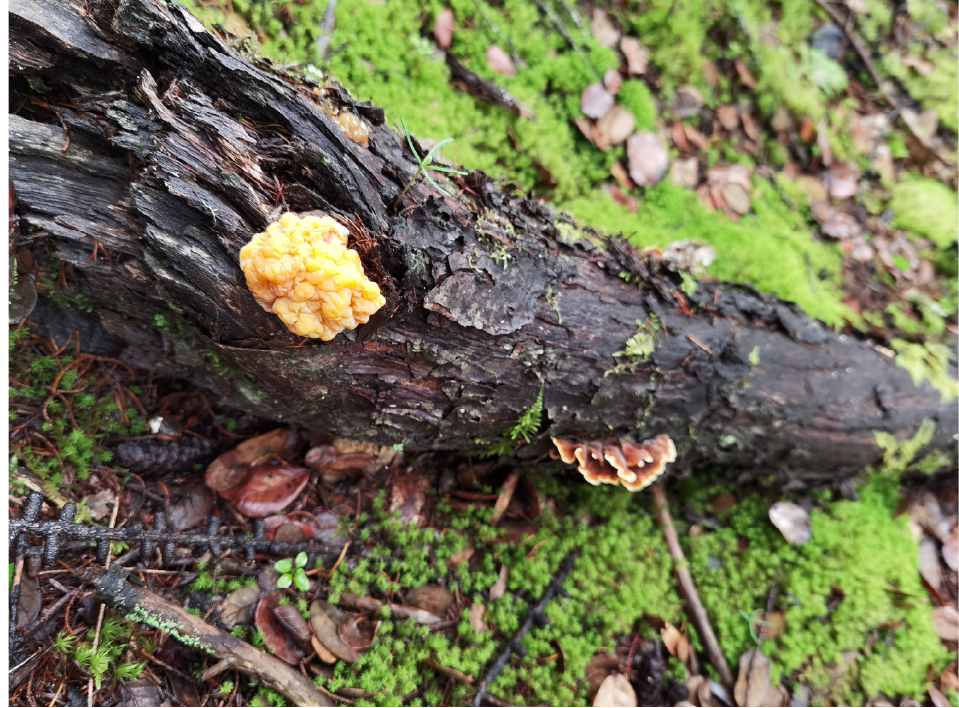
Figure 1. Fruiting bodies of N. aurantialba .